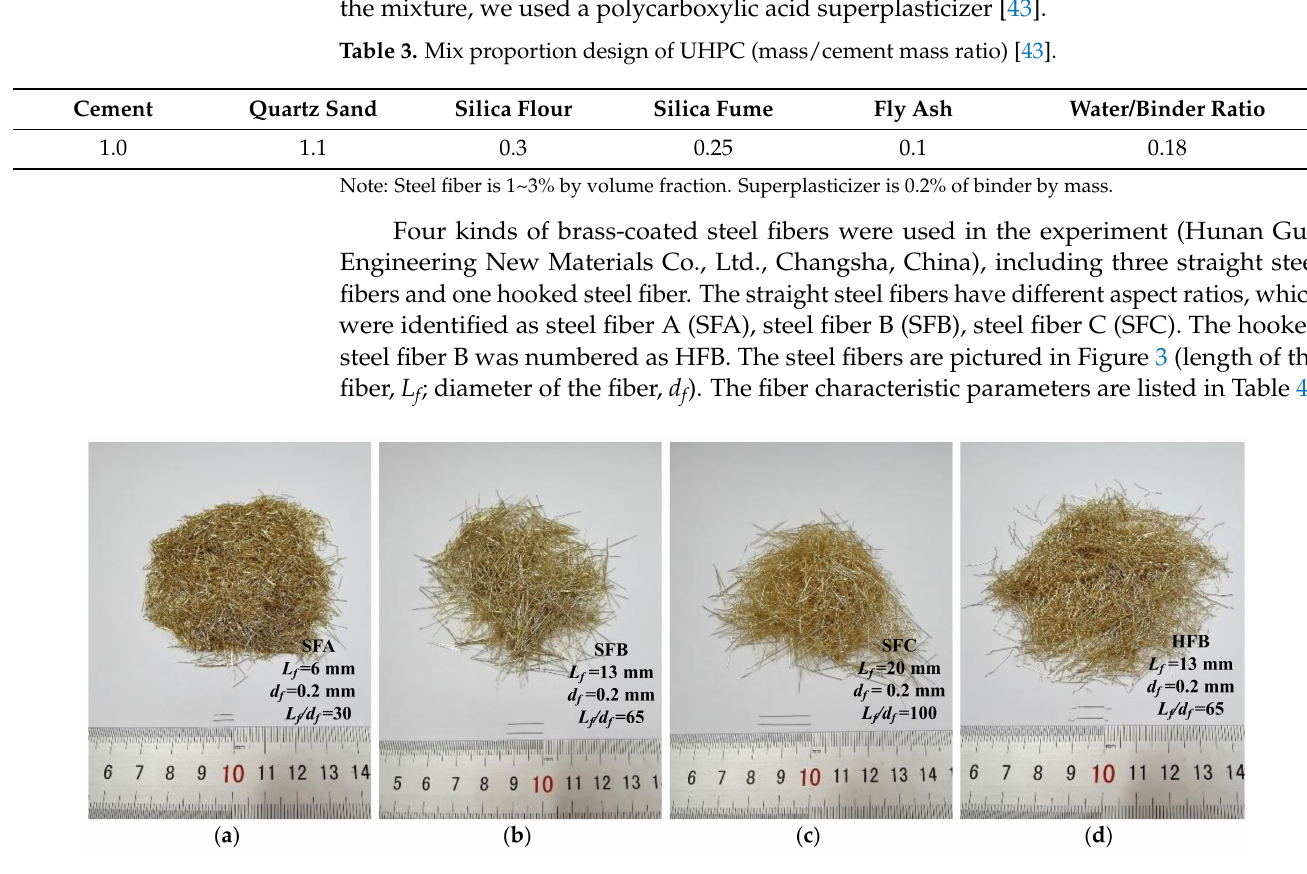
Figure 3. Different types of steel fibers: ( a ) SFA; ( b ) SFB; ( c ) SFC; ( d )